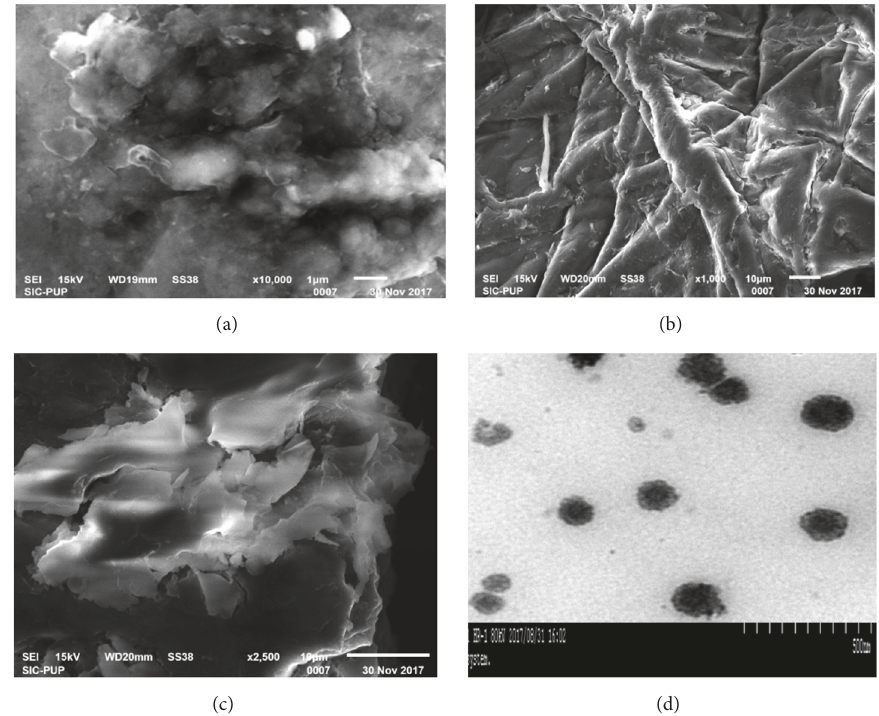
Figure 4: SEM images of (a) FX, (b) CH, and (c) drug loaded optimized nanoparticles and TEM image of (d) drug loaded optimized nanoparticles.